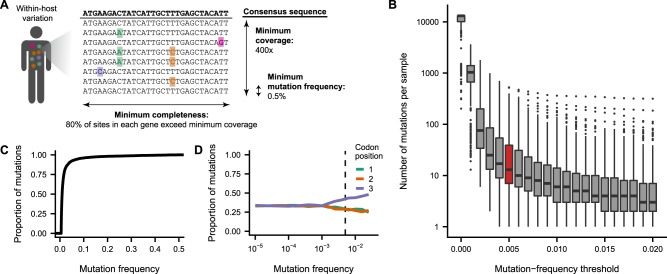
Within-host mutation calling criteria. (A) Within-host mutations were called when a nonconsensus base reached a frequency of 0.5 per cent at a site with at least 400× sequencing coverage. We analyzed only viral samples in which >80 per cent of the sites in each sequenced gene had ≥400× coverage. (B) The number of mutations called in each viral sample declines as the minimum mutation-frequency threshold increases. Outlier samples with high within-host variation were included in this plot but excluded from subsequent analyses (Supplementary Fig. S3). (C) Most within-host mutations called above a frequency of 0.5 per cent are present at <5 per cent frequency. (D) Within-host mutations at higher frequencies are more likely to be located at the third codon position. Sequencing errors, which occur at low frequencies, are expected to be evenly distributed across all three codon positions. In contrast, high-frequency mutations are disproportionately located at the third codon position, where mutations are often nonsynonymous, suggesting that mutations at higher frequencies are more likely to represent true viral mutations that have experienced purifying selection. The dashed line indicates the 0.5 per cent mutation-frequency threshold used in this study.